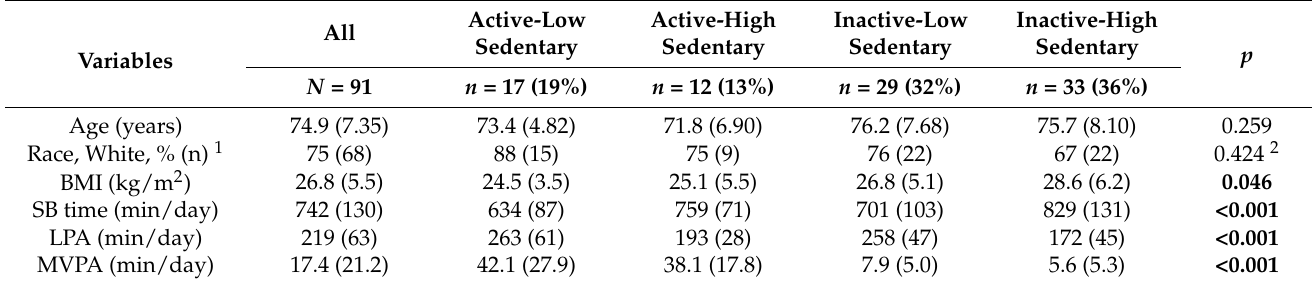
Table 1. Characteristics of study participants, expressed as means (SD).